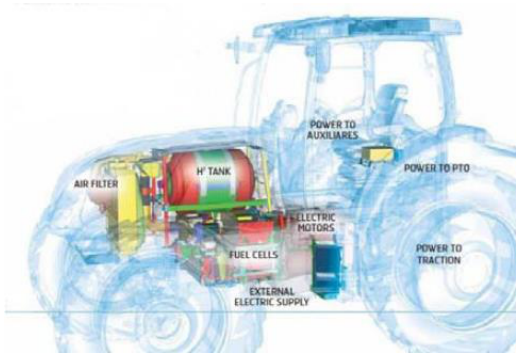
Fig. 22. New Holland NH2 hydrogen-powered tractor [23]